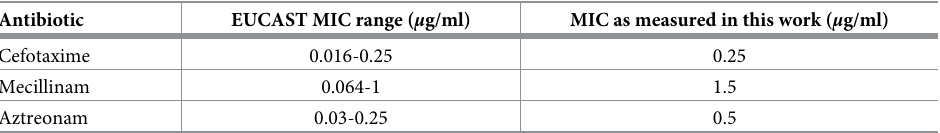
Table 2. MIC values for the antibiotics used in this